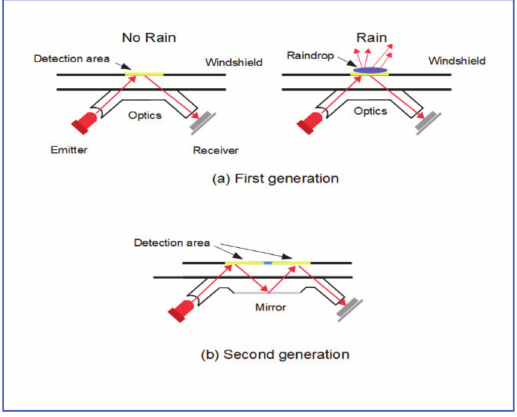
Figure 1. Optical raindrop detection using NIR sensors